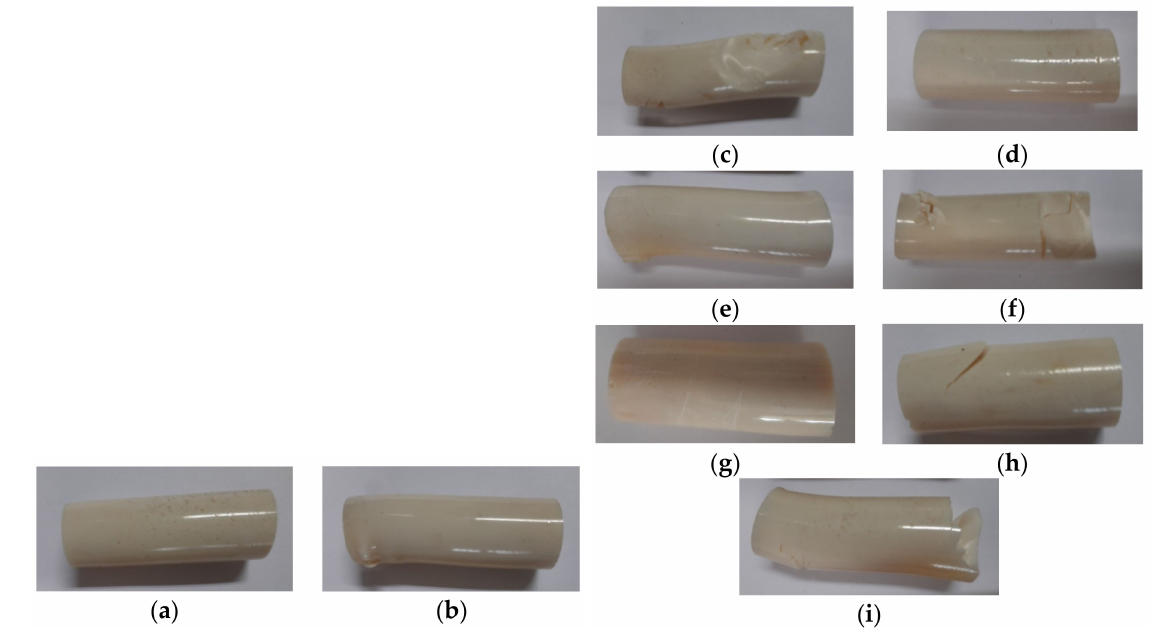
Figure 9. Images of some CaCO 3 -filled epoxy adhesives cold-cured by triethylenetetramine (TETA) curing agent (i.e., system E57/Z-1/100:10/1CaCO 3 ) after mechanical (in compression mode) tests: ( a ) DeW1; ( b ) DeW2; ( c ) DeW3; ( d ) DiW1; ( e ) DiW2; ( f ) DiW3; ( g ) SW1; ( h ) SW2; ( i )